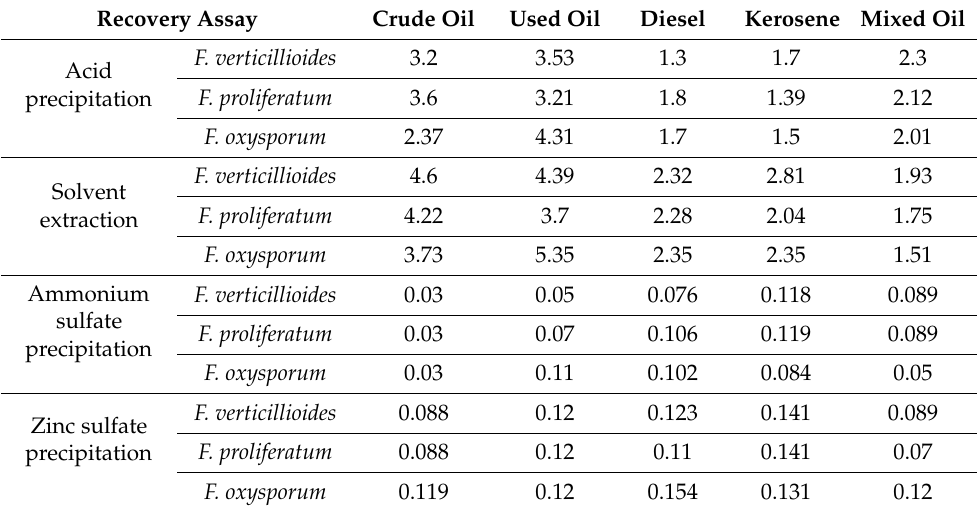
Table 6. Recovery of biosurfactants produced by Fusarium spp.